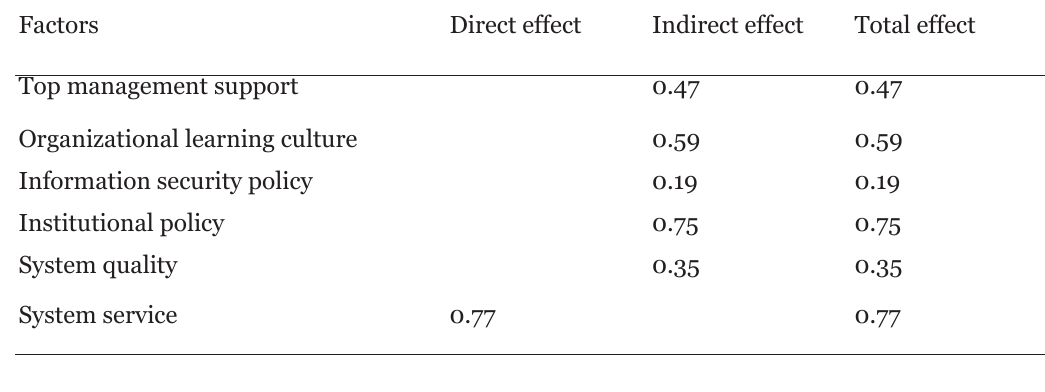
Direct/Indirect/Total Effects of Variables on Organizational